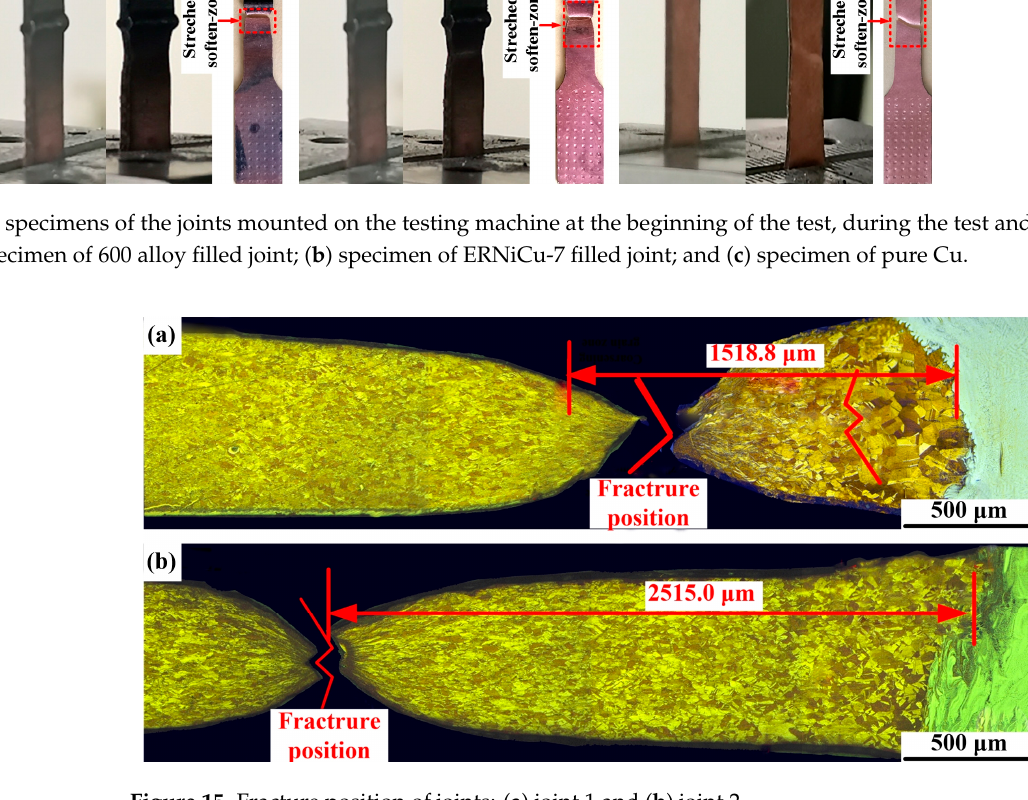
Figure 15. Fracture position of joints: ( a ) joint 1 and ( b ) joint 2.